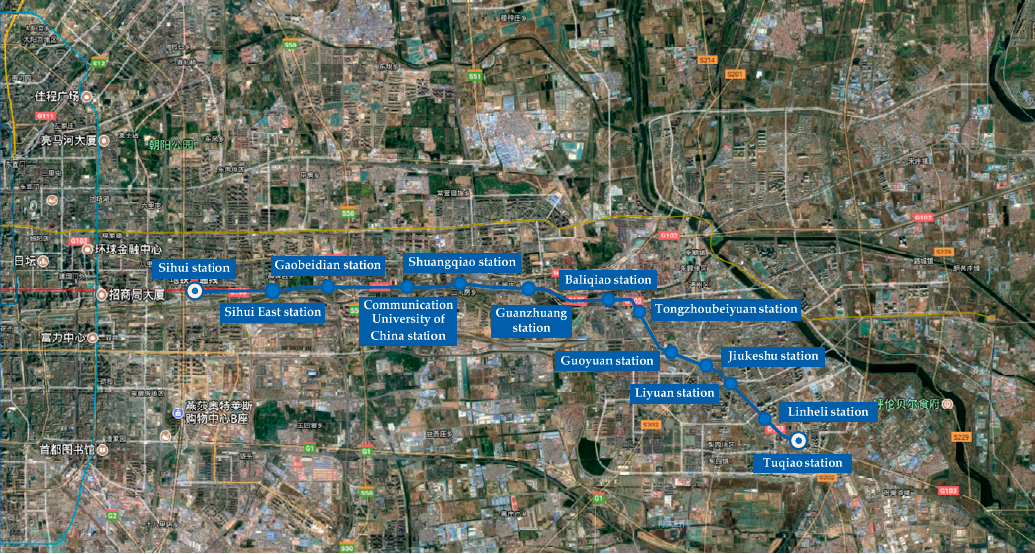
Figure 7. Robust mechanism of timetabling process according to the distributed time. Table 1. Model parameters following appearing orders.